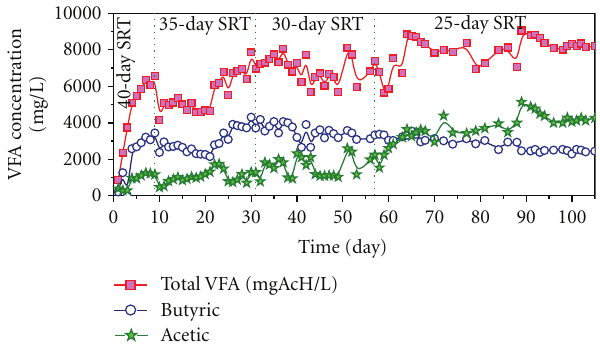
Figure 6: Evolution of total VFA, butyric, and acetic